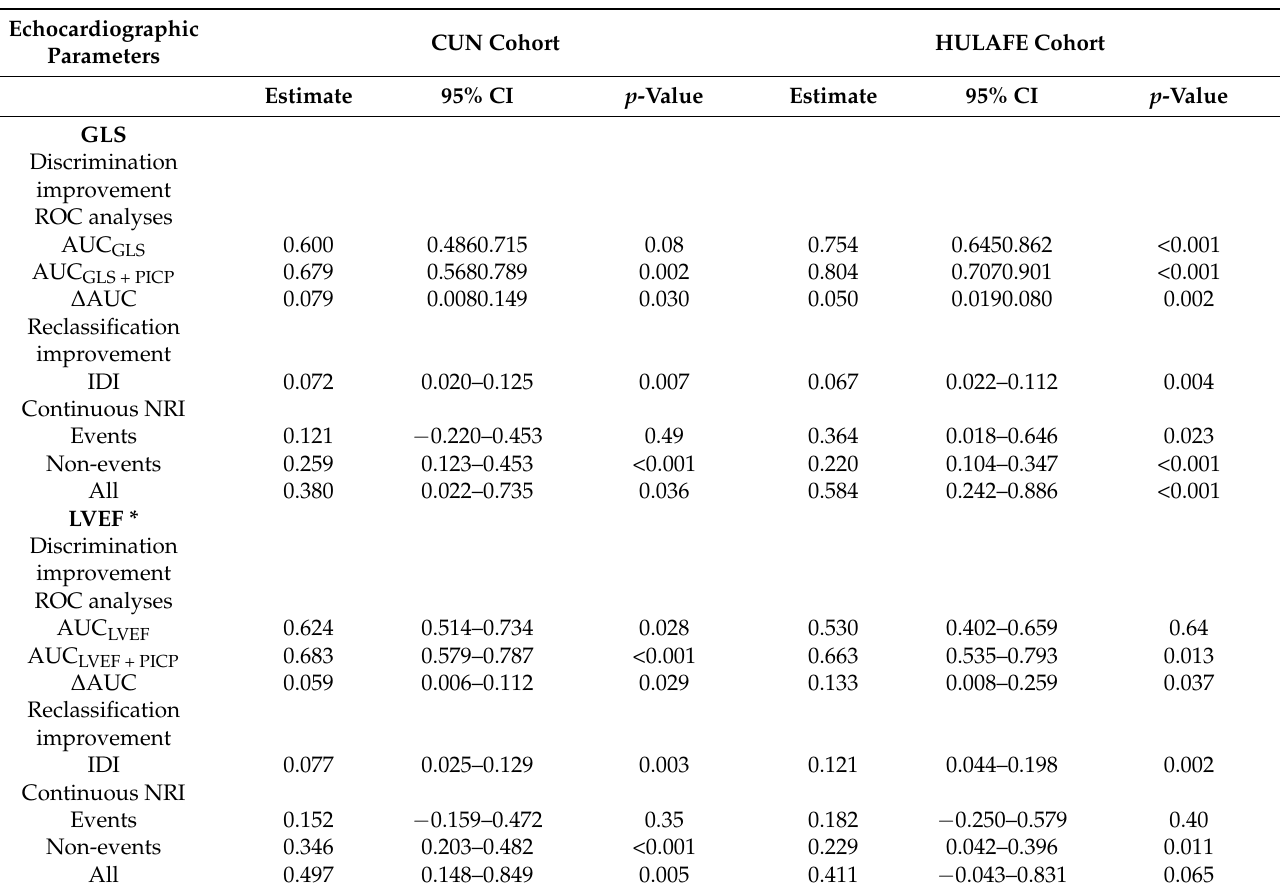
Table 6. Prediction improvement evaluation after adding PICP to models including GLS and LVEF changes from baseline to